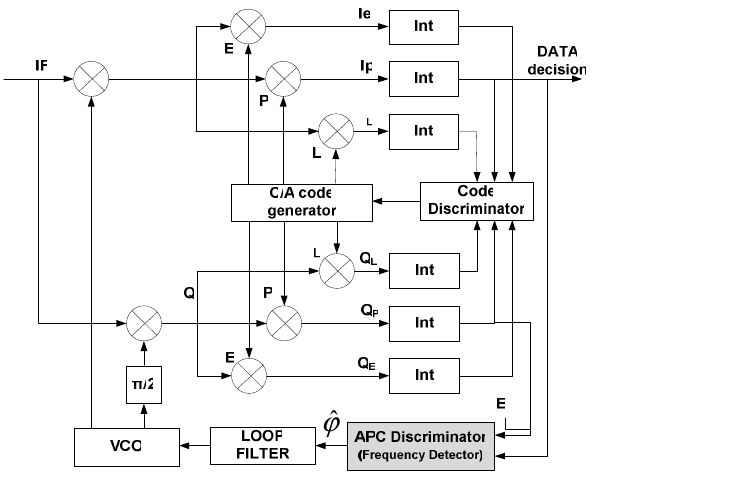
Figure 3 – General configuration used for signal tracking in the GPS software receiver, with the integrated DLL and PLL Рис . 3 – Принципиальная схема отслеживания сигнала в программируемом GPS приемнике , с интегрированными DLL и